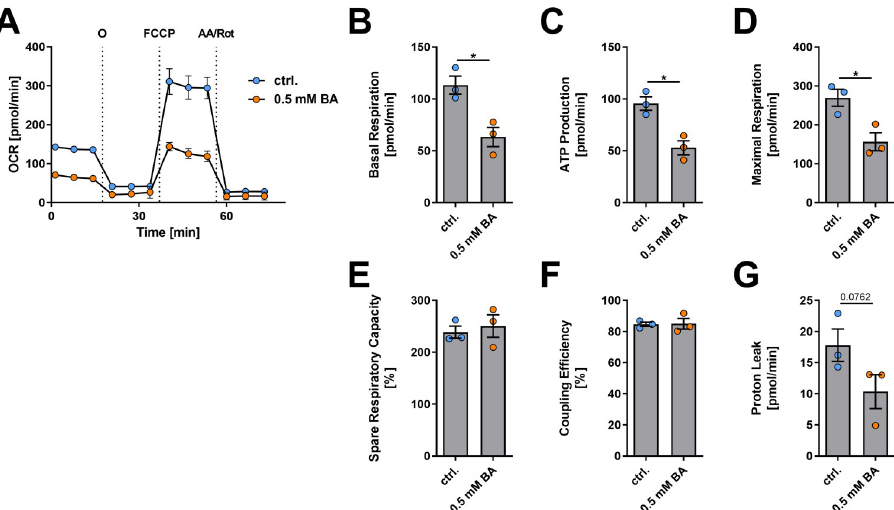
Fig 7. Seahorse analysis of BA effects on mitochondrial metabolism in isolated murine B cells. (A) OCR measurements of isolated murine B cells in the Mito-Stress assay after one day of incubation with 0.5 mM BA. The